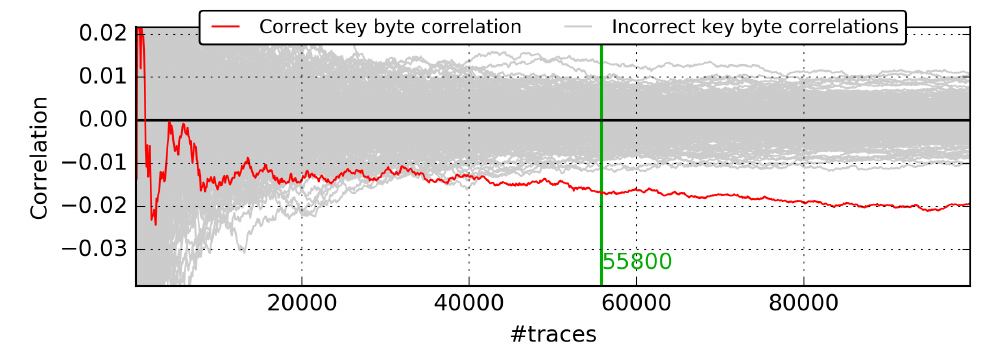
Figure 4: Example of a successful key recovery after 55 , 800 traces, where the correlation with the correct key guess is less than 1 . 5 times the second lowest correlation